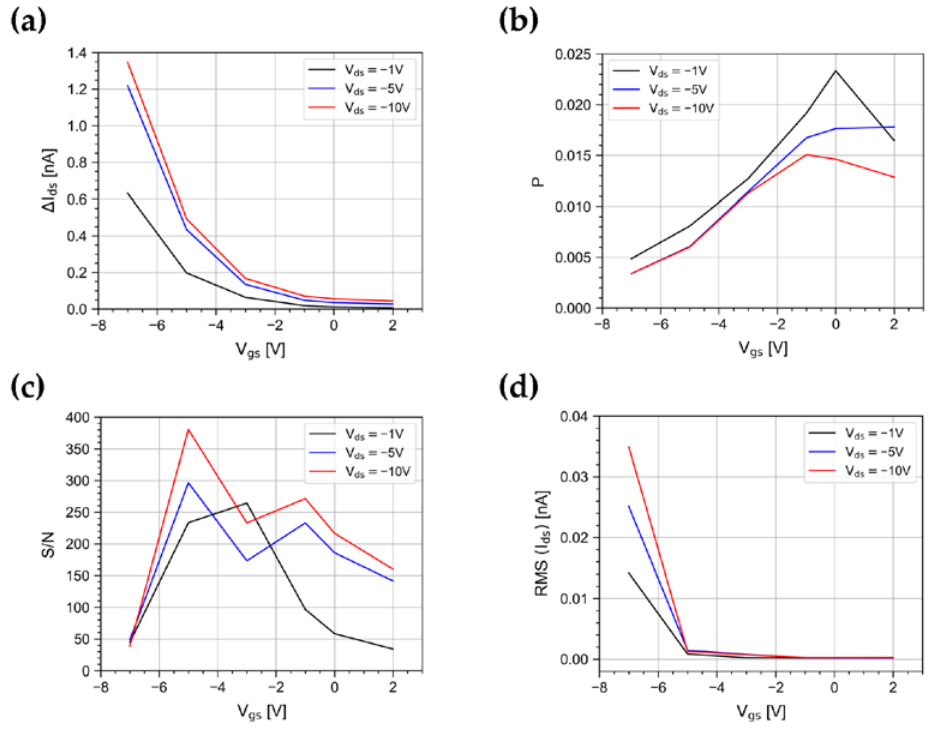
Figure 5. ( a ) Responsivity, ( b ) photosensitivity, ( c ) signal-to-noise ratio, and ( d ) root mean square of the I ds dark current as a function of V gs for V ds = −1, −5, −10 V at an irradiance of 500 nW/cm 2 .